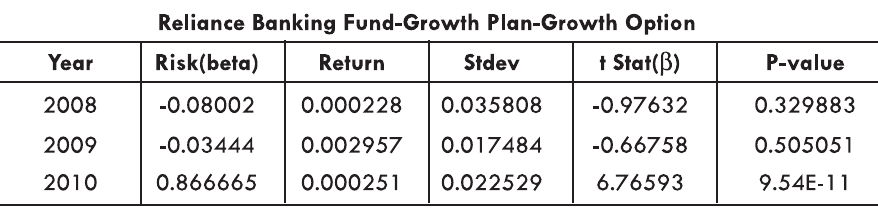
Table 8 : Risk and Returns of Reliance Banking Fund-Growth Plan-Growth Option Scheme during the Study Period (2008 to